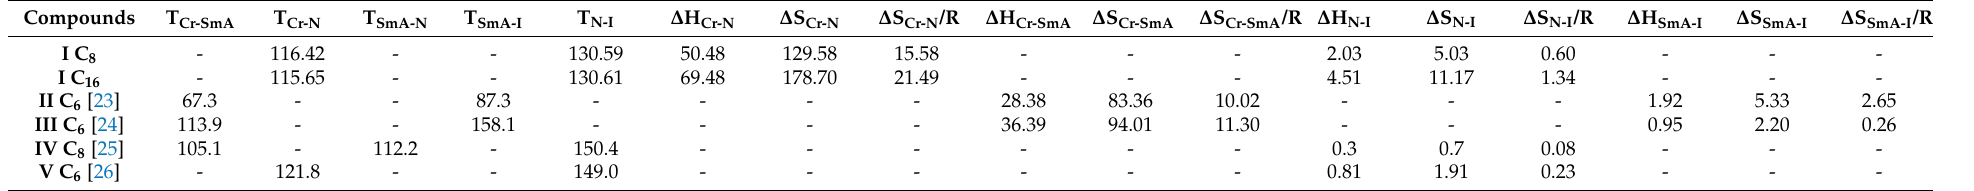
Table 1. Phase transition temperatures ( ◦ C) at 10.0 ◦ C/min., enthalpy of transition ∆ H (kJ/mol), the entropy of transition ∆ S (J/mol.K), and normalized entropy